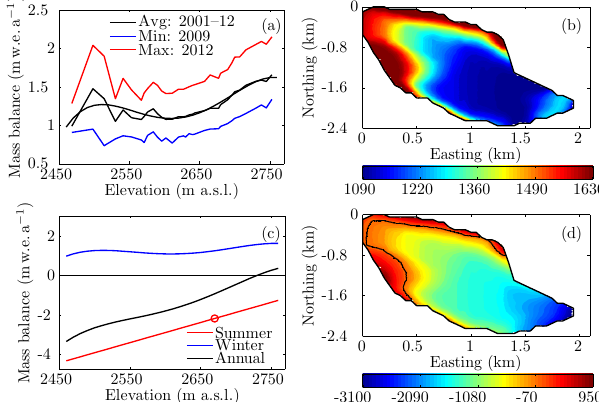
Fig. 2. Present-day geometry of Haig Glacier. (a) Surface topogra- phy (ma.s.l.) of the glacier, obtained from the bilinear interpolation of the 2005 DEM based on the ASTER imagery. (b) Interpolated bedrock topography (ma.s.l.) based on the 16 GPR subglacial im- ages. (c) Glacier ice thickness (m) calculated from surface and basal topographies. Black lines in (a–c) represent the present-day glacier outline and assumed central flowline. (d) Longitudinal profile of glacier geometry along the central flowline. Note that hereinafter we use “local” easting and northing with reference to (619.1kmE, 5620.3kmN).